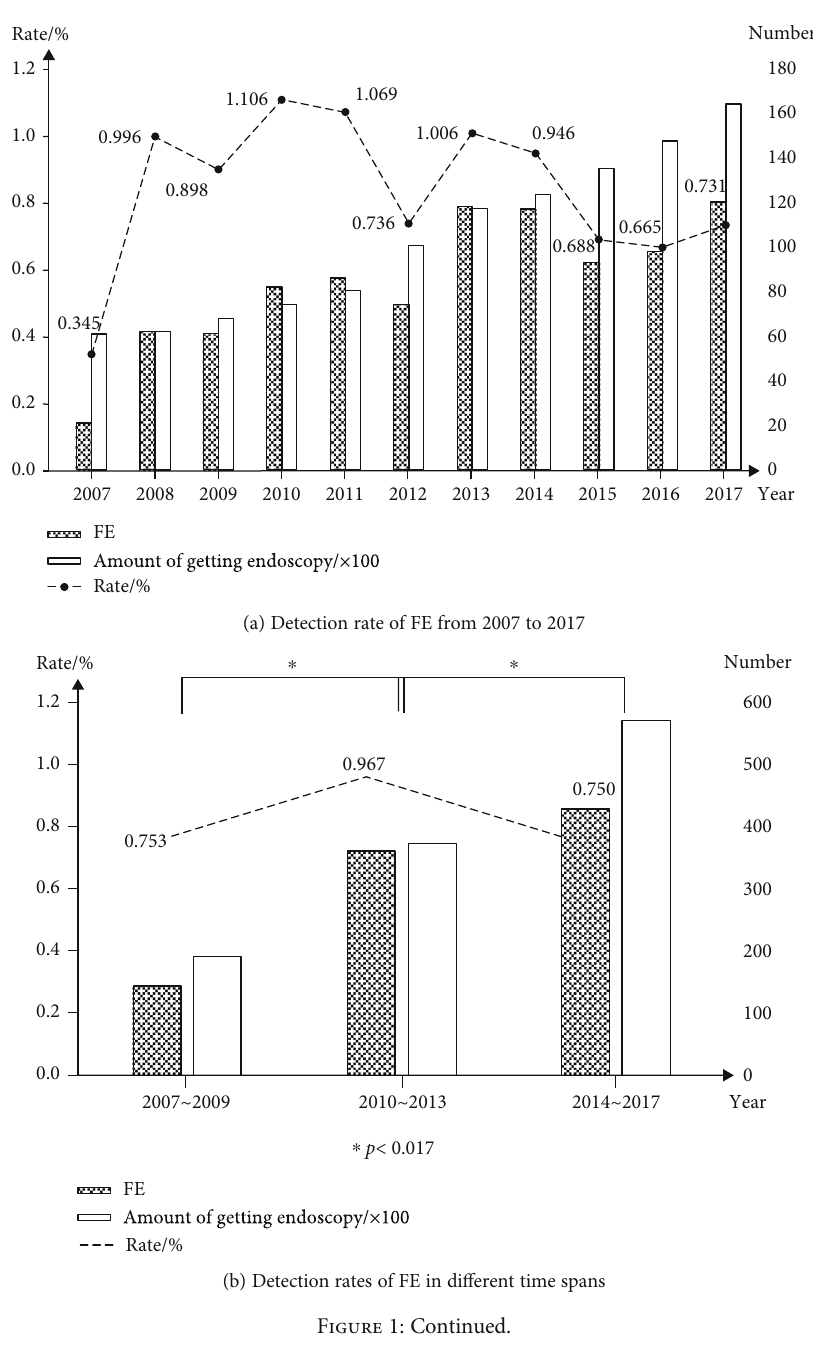
(b) Detection rates of FE in di ff erent time